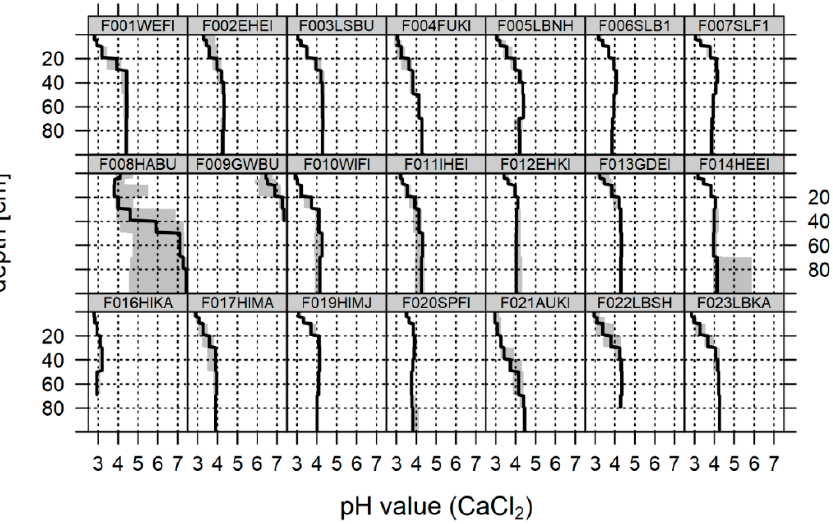
Figure 7. Depth profiles of base saturation in the mineral soil for the most recent soil inventory (cf. Figure 3) at the permanent study plots in Lower Saxony. The solid line describes the median of six composite samples taken at 24 locations and the grey areas the error range (5th and 95th percentile). The groups 1, 2, and 3 are defined as soils with 100% base saturation in the